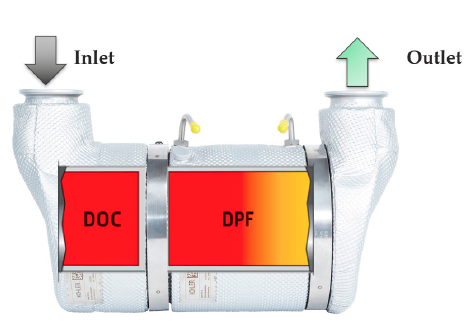
Figure 9. Exhaust after-treatment system of KDI 1903 TCR engine.